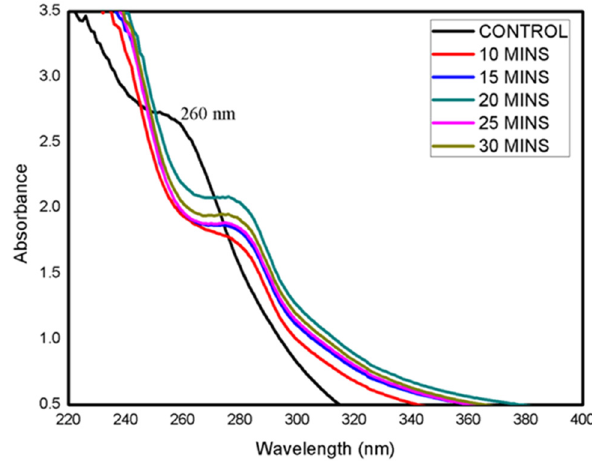
Figure 6: The optical spectra present the e ff ect of the reaction time of green synthesis on the absorption spectra of Pt NPs ( reprinted from ref. [ 124 ] , copyright 2020, with permission from Elsevier )